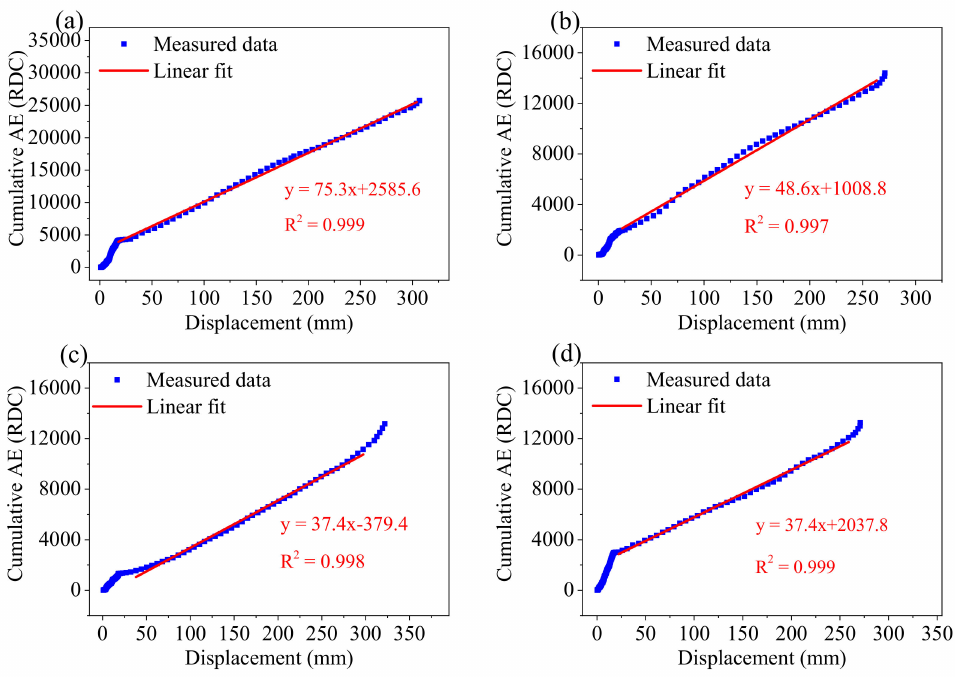
Figure 13. Linear relationship between cumulative ring down count (RDC) and displacement. ( a – d ) show the relationship for the four experiments. All data points are the moving average value of 5